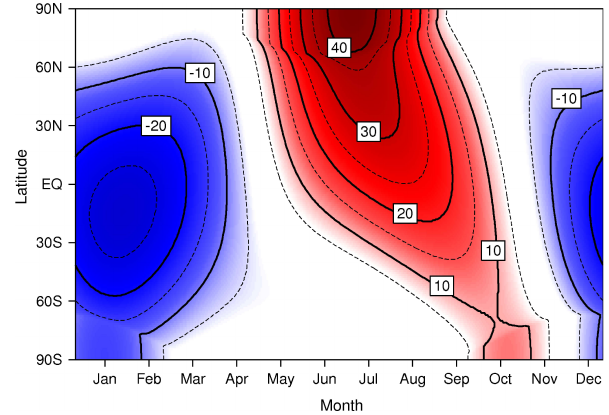
Fig. 2. Latitudinal distribution of insolation in Wm − 2 at the top-of-the-atmosphere for 7kyr BP minus present-day, calculated according to Berger (1978), through the